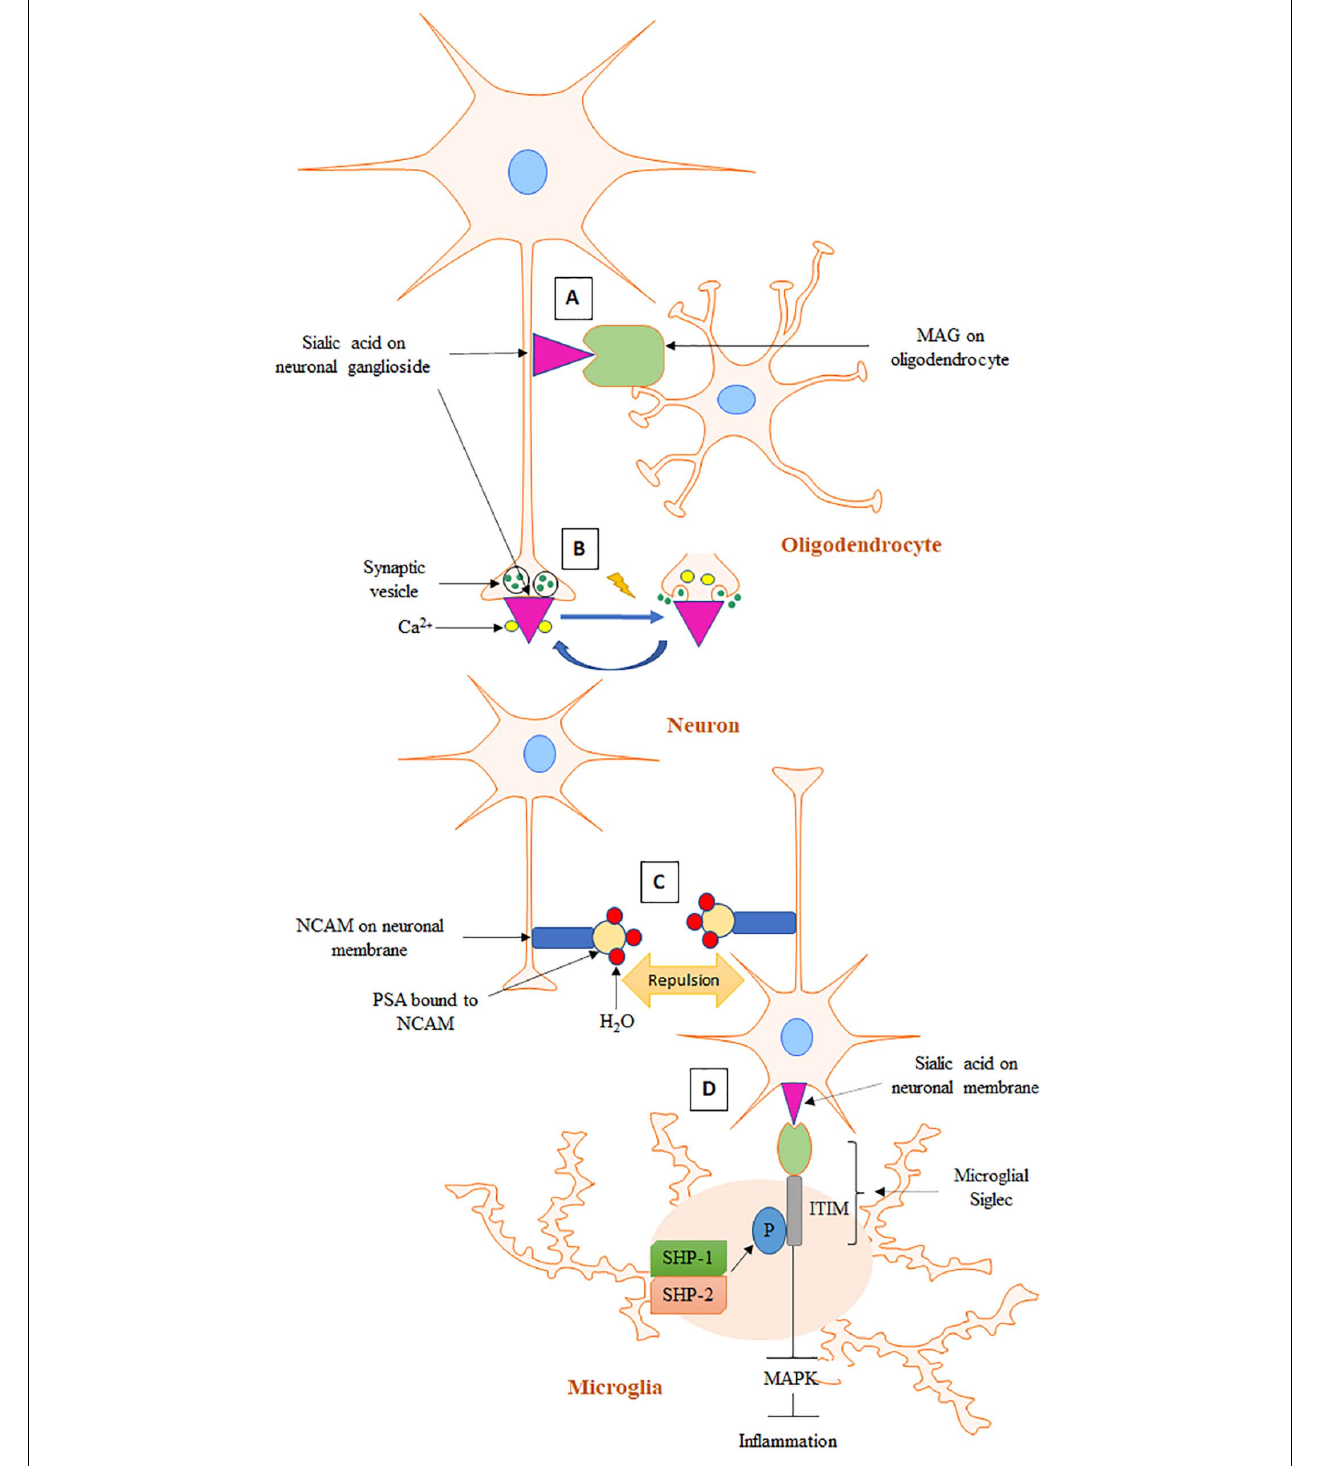
FIGURE 1 | Schematic representation of sialic acid functions in the brain. (A) In the process of axon myelination, MAG on oligodendrocyte interacts with sialic acid of ganglioside on axonal membrane. (B) At resting state, Ca 2 + is bound to negatively charged sialic acid on synaptic membrane. In the event of an action potential, Ca 2 + is released from sialic acid and enters presynapse for exocytosis and neurotransmitter release. (C) PSA on NCAM causes stereochemical repulsion that prevents homophilic contacts of NCAMs on opposing cells. (D) Sialic acid binds to microglial Siglec, which induces phosphorylation of ITIM present on the cytosolic domain of Siglec. Phosphorylated ITIM recruits SHP-1 and SHP-2 leading to inhibition of MAPK activity and the subsequent inflammatory cascade.